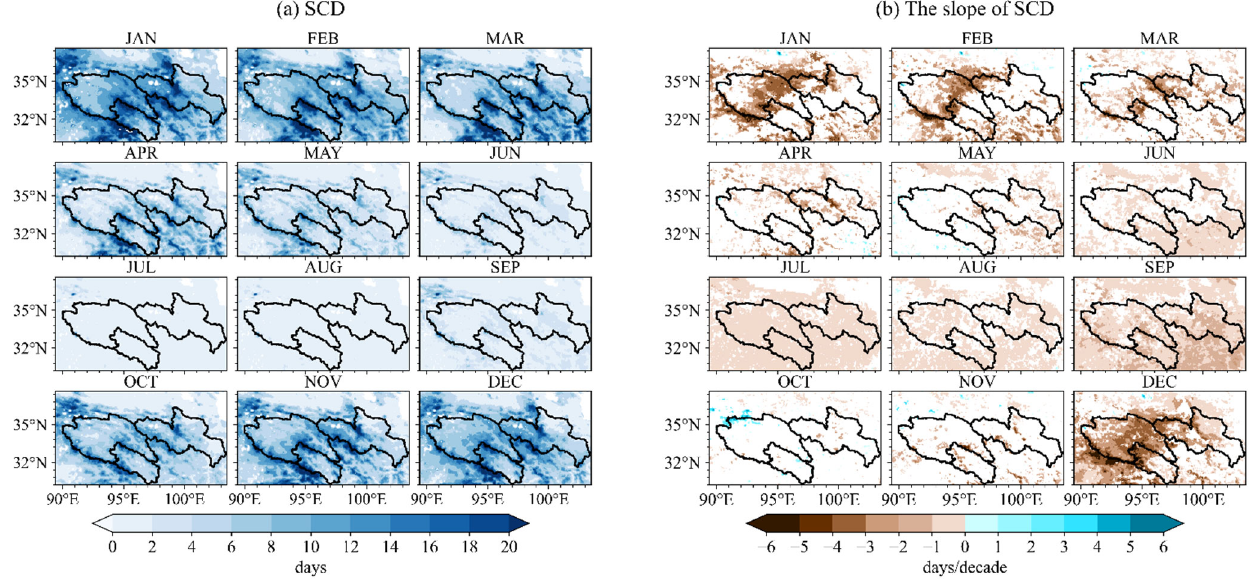
Figure 6. SCD ( a ) and its trends ( b ) (Pass significance test at 90% confidence